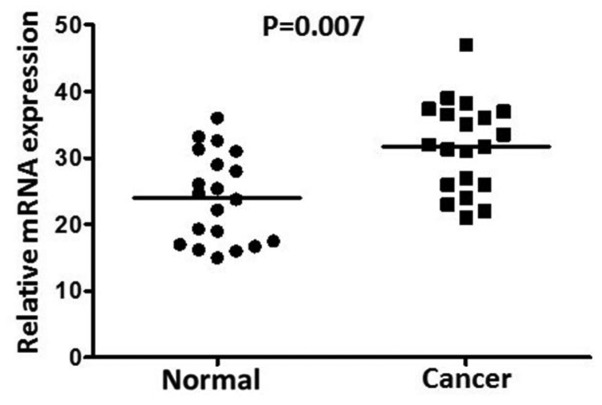
Elevated mRNA expression of astrocyte elevated gene-1 in normal gastric mucosa and gastric cancer tissues as assessed by real-time reverse transcription polymerase chain reaction (n=20; P=0.007). Horizontal lines represent the mean and data are presented as three individually matched pairs of normal and neoplastic tissue samples.